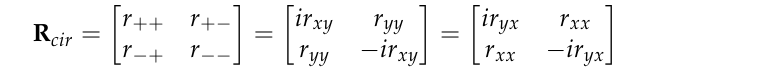
( b ) Figure 7. Surface current distributions at their resonance frequencies of ( a ) 10 GHz; ( b ) 23 GHz. 3.3. Parametric Analysis To investigate the sensitivity of AR response on different parts of the unit cell, a parametric analysis was conducted against some critical unit cell dimensions, as shown in Figure 8. Since the parameters l 0 , l 1 , w and g of the unit cell were less sensitive for variations of dimension, a 100 µm simulation step was applied for this design. Figure 8a depicts the variations of AR for different lengths l 0 . It can be observed that the operation region of 3 dB AR shifted slightly towards a lower frequency as l 0 varied from 5.24 mm to 5.44 mm. A similar phenomenon could be observed for the parameter l 1 in Figure 8b. It should be noted that the dimensions of the metallic patch determined the inductance